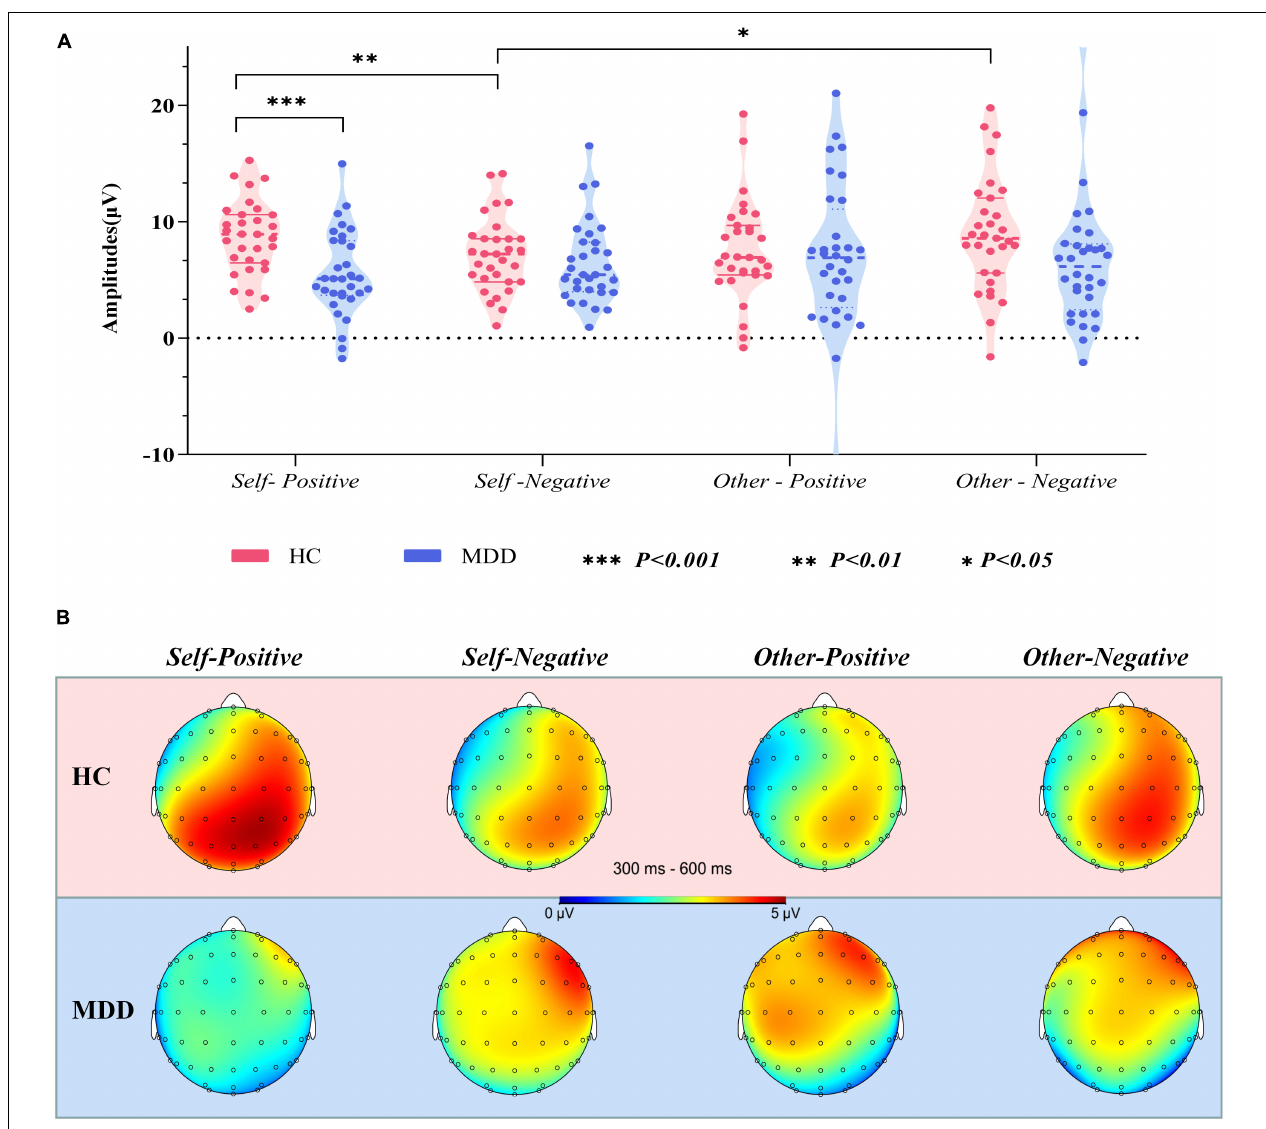
FIGURE 4 | (A) Violin plots of pooled (Cz, CPz, and Pz) averaged go-P3 amplitudes in different groups and conditions. (B) Topographical distribution of grand averaged go-P3 within a time window of 300–600 ms post-stimuli under different conditions. MDD, major depressive disorder; HC, healthy control; SD, standard